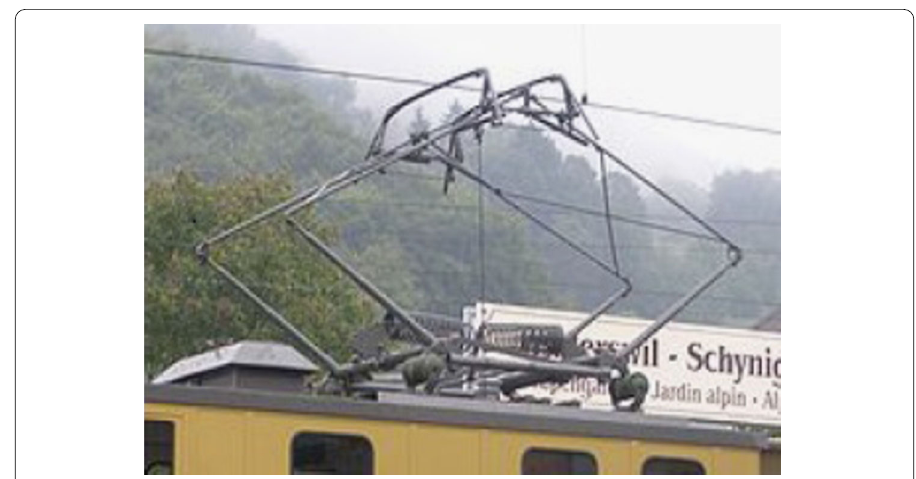
Figure 1 Physical application: Collection pantograph